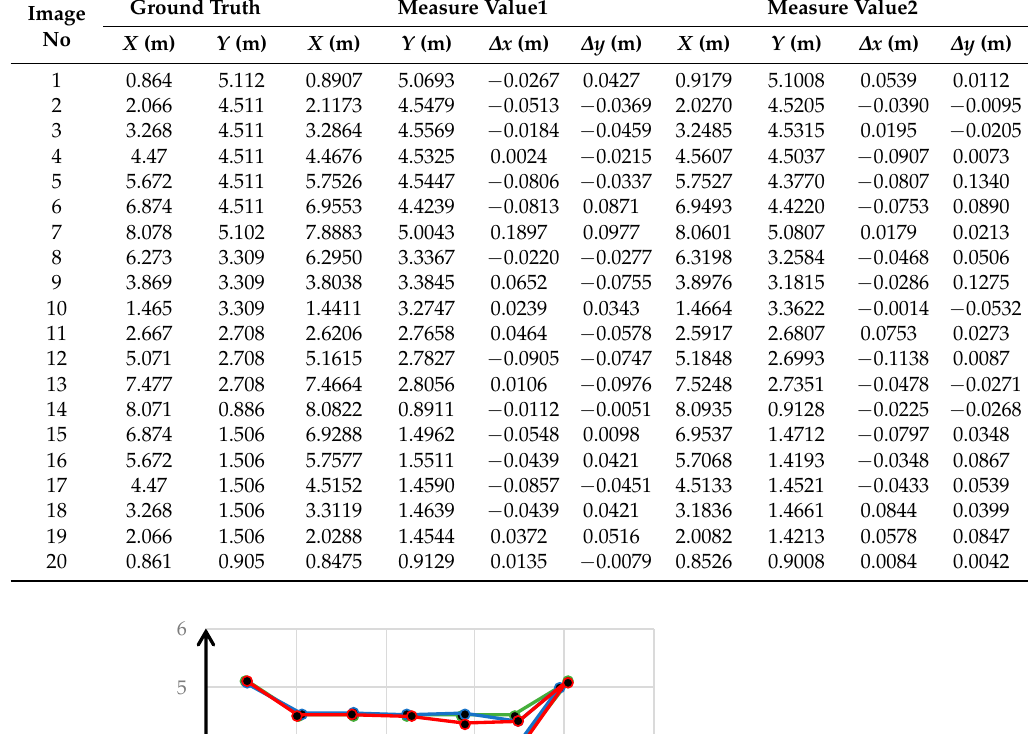
Table 1. Positioning accuracy of the Samsung Galaxy S8 smartphone.